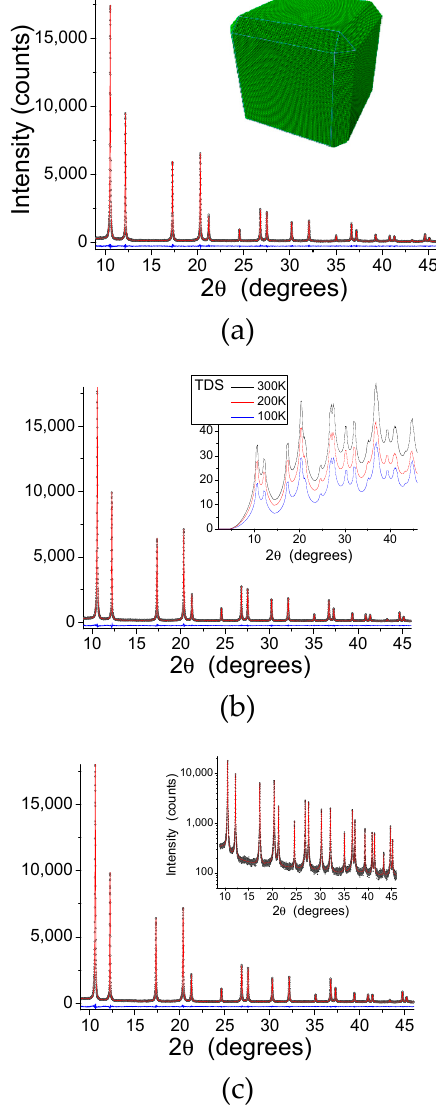
Figure 5. Whole powder pattern model (WPPM) results. X-Ray Diffraction (XRD) patterns (circle), model (line), and difference (residual, line below) at 300 ( a ), 200 ( b ), and 100 K ( c ). Insets: in ( a ), refined shape of the truncated nanocube; in ( b ), Thermal Diffuse Scattering (TDS) component at 100 (blue), 200 (red), and 300 K (black); in ( c ), intensity log scale plot.